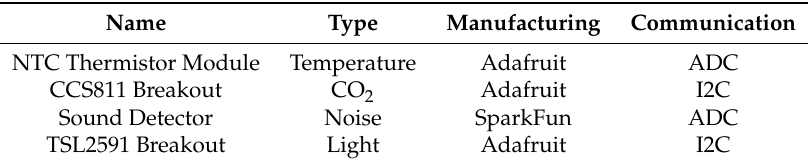
Table 2. Sensors used in the Objects Layer.